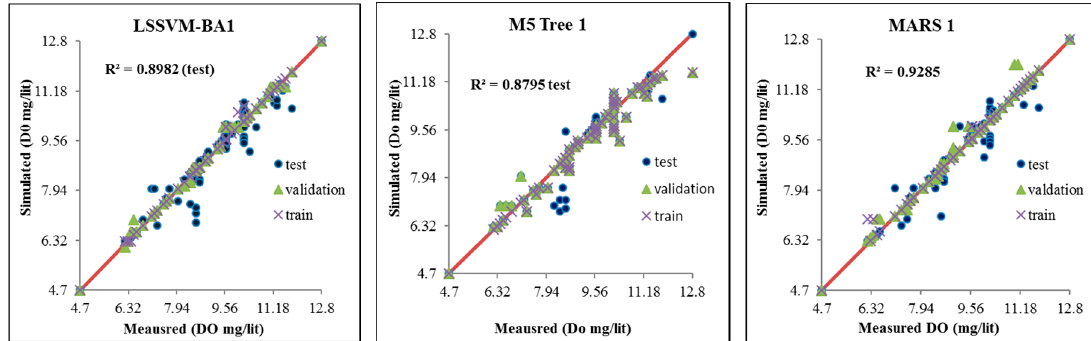
Figure 5. Scatter plot of observed and simulated DO concentration by three predictive models during model training, validation, and testing at USGS 10133800.